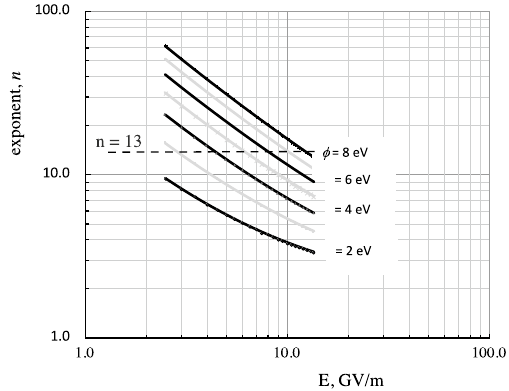
Figure 4. The local electric field, E local , can be obtained from the exponent n from field emission measurements I ∼ E n and estimates of the work function φ , 20 . Experimental data shows that n ∼ 14 for radiation levels and n ∼ 13 for field emission 9